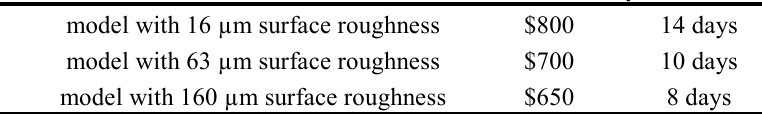
Table 4.Wind tunnel model time and cost summary